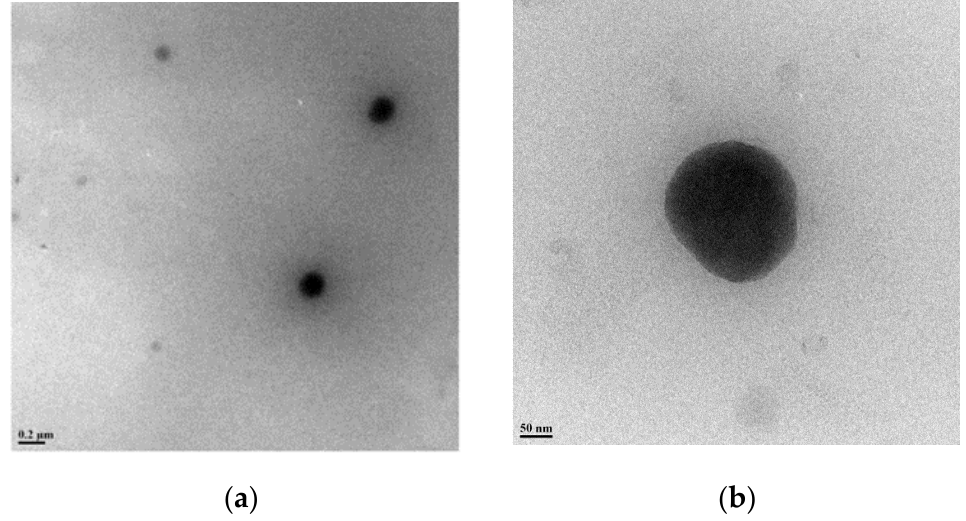
Figure 2. Morphological characterization of OFP-CD. TEM images of OFP-CD in ( a ) low resolution and ( b ) high resolution modes, indicating the presence of spherical nanoparticles.